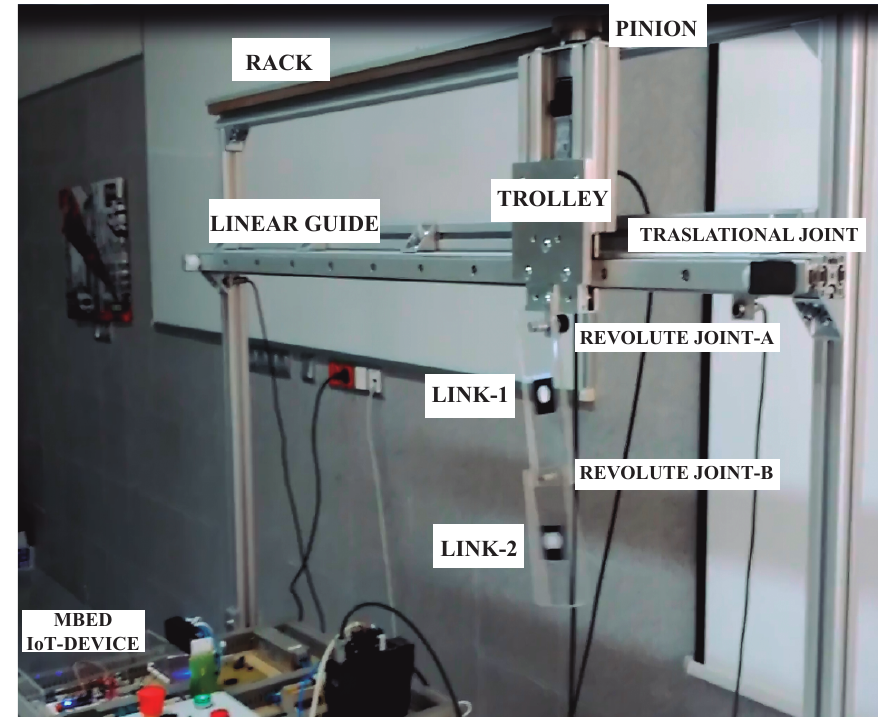
Figure 24. Mini Overhead Crane functional mock-up